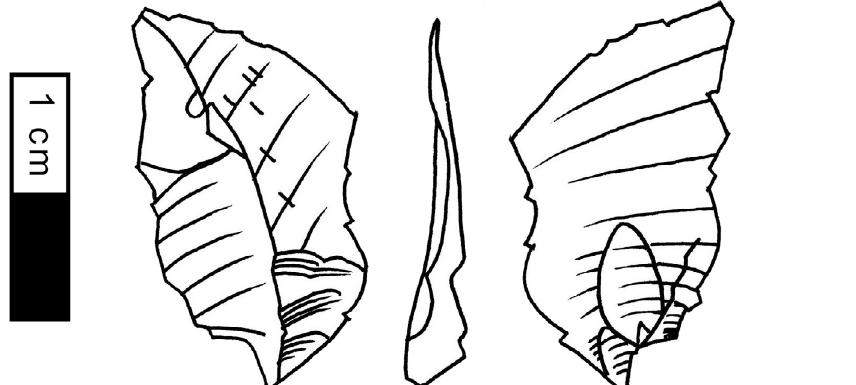
Figure 24. Dorsal ridge following flake Gl11 (22x13x4 mm) (drawing by the